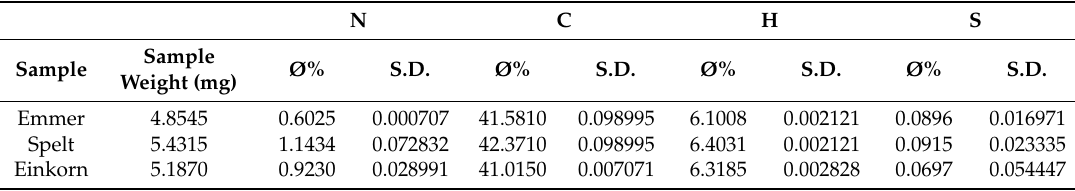
Table 3. Elemental composition of cha ff .